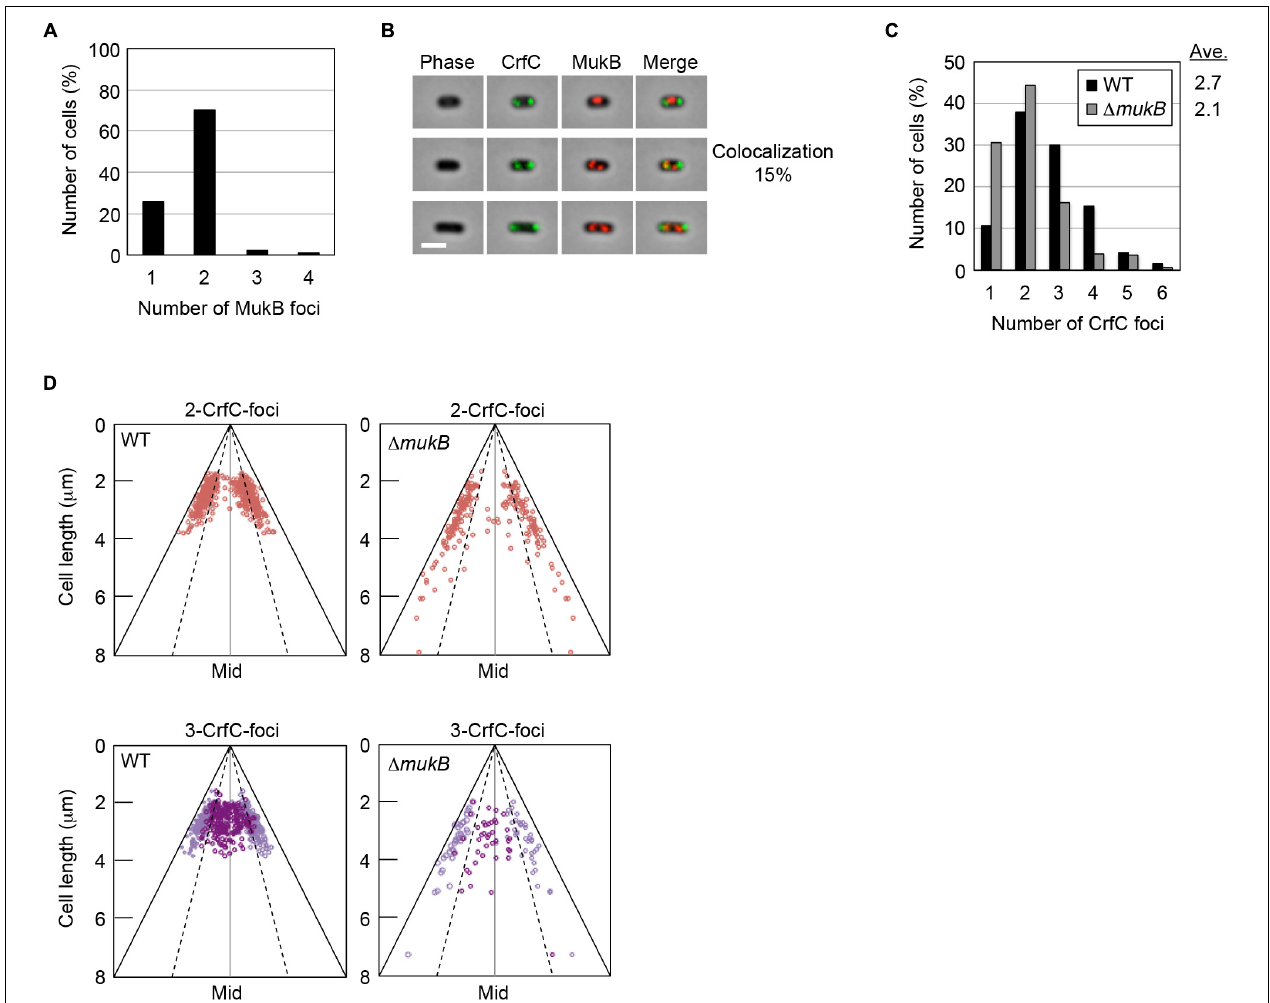
FIGURE 3 | Subcellular localization of CrfC and MukB. (A) Percentages of MECS111-K cells containing one to four MukB foci. Cells with more than four foci were not detected. In total, 316 cells were analyzed. (B) Representative images of fluorescent foci and the morphology of MECS111-K cells. Cells containing one MukB focus (upper panel), two MukB foci colocalizing with CrfC (middle panel), or two MukB foci not colocalizing with CrfC foci (lower panel) are shown. Scale bar is 2 µ m. (C) Percentages of MECS91-K (WT; black bars) and MECS144 ( (cid:49) mukB ; gray bars) cells containing one to six CrfC foci. In total, 665 (WT) and 245 ( (cid:49) mukB ) cells were analyzed. Ave; average number of CrfC foci. (D) Subcellular positioning of CrfC in MECS91-K (WT) and MECS144 ( (cid:49) mukB ) cells. Cells bearing two CrfC foci (upper panel) or three CrfC foci (lower panel) were analyzed. Mid,